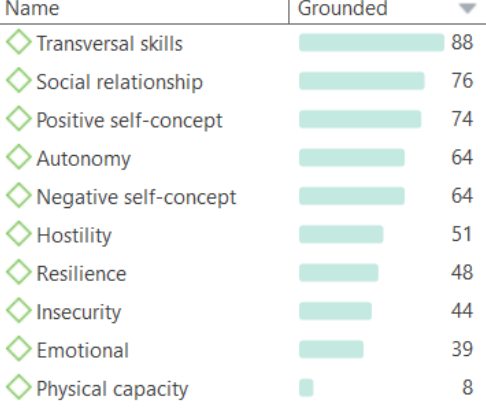
Figure 2. Rooting of the codes emerged inductively.